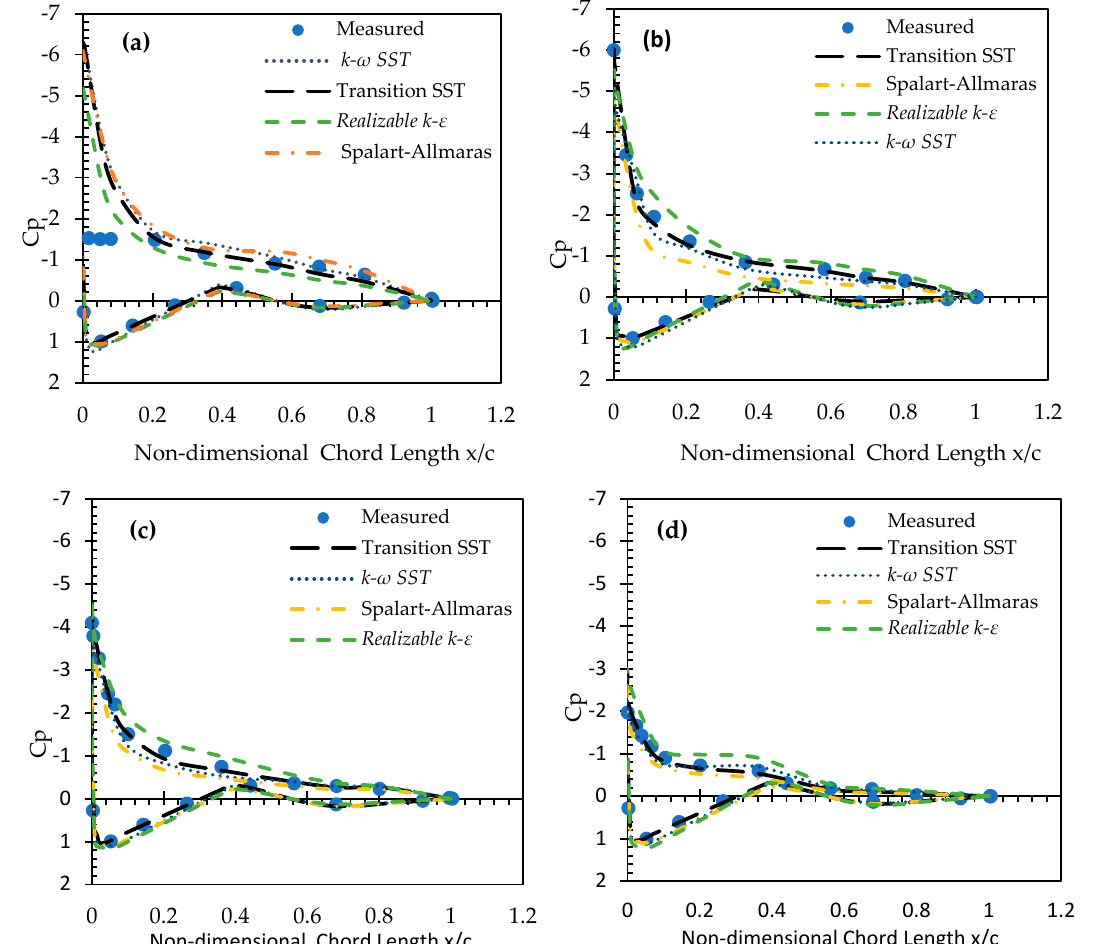
Figure 8. Comparison of span ‐ wise pressure distribution among the different turbulence models and NREL measurements at 10.2 m/s for: ( a ) 47% section, ( b ) 63% section, ( c ) 80% section, and ( d ) 95% section.